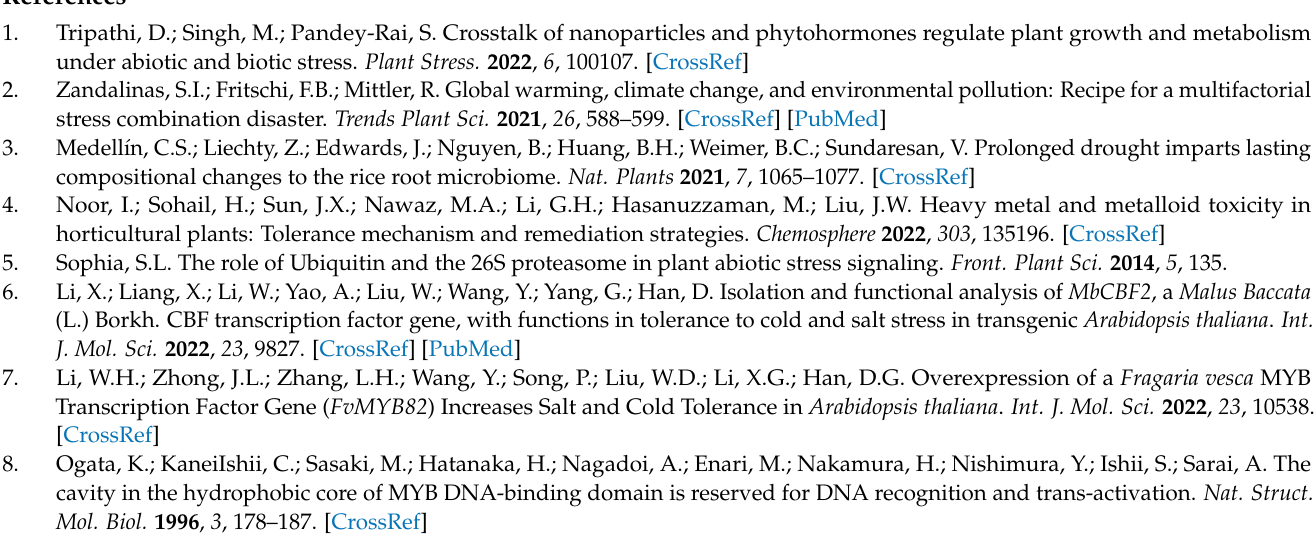
Table S1: List of primers used in this